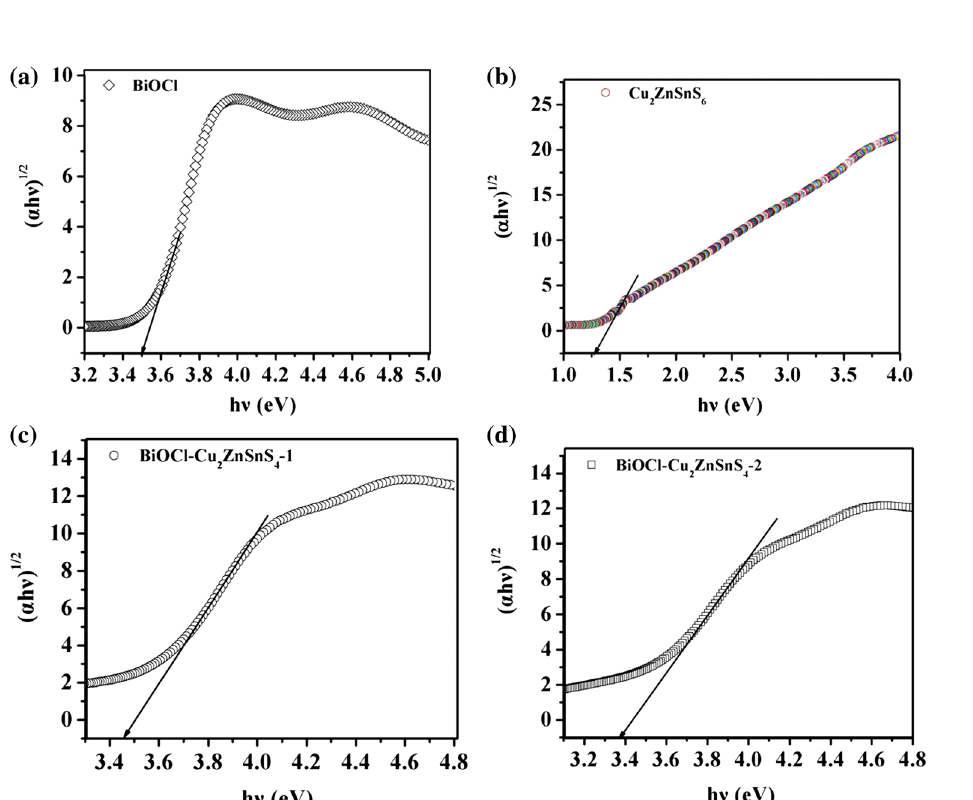
Fig. 5 Tauc plots of ( αhv ) 1/2 versus photon energy ( hv ) of a BiOCl microspheres, b Cu Cu 2 ZnSnS 4 -2